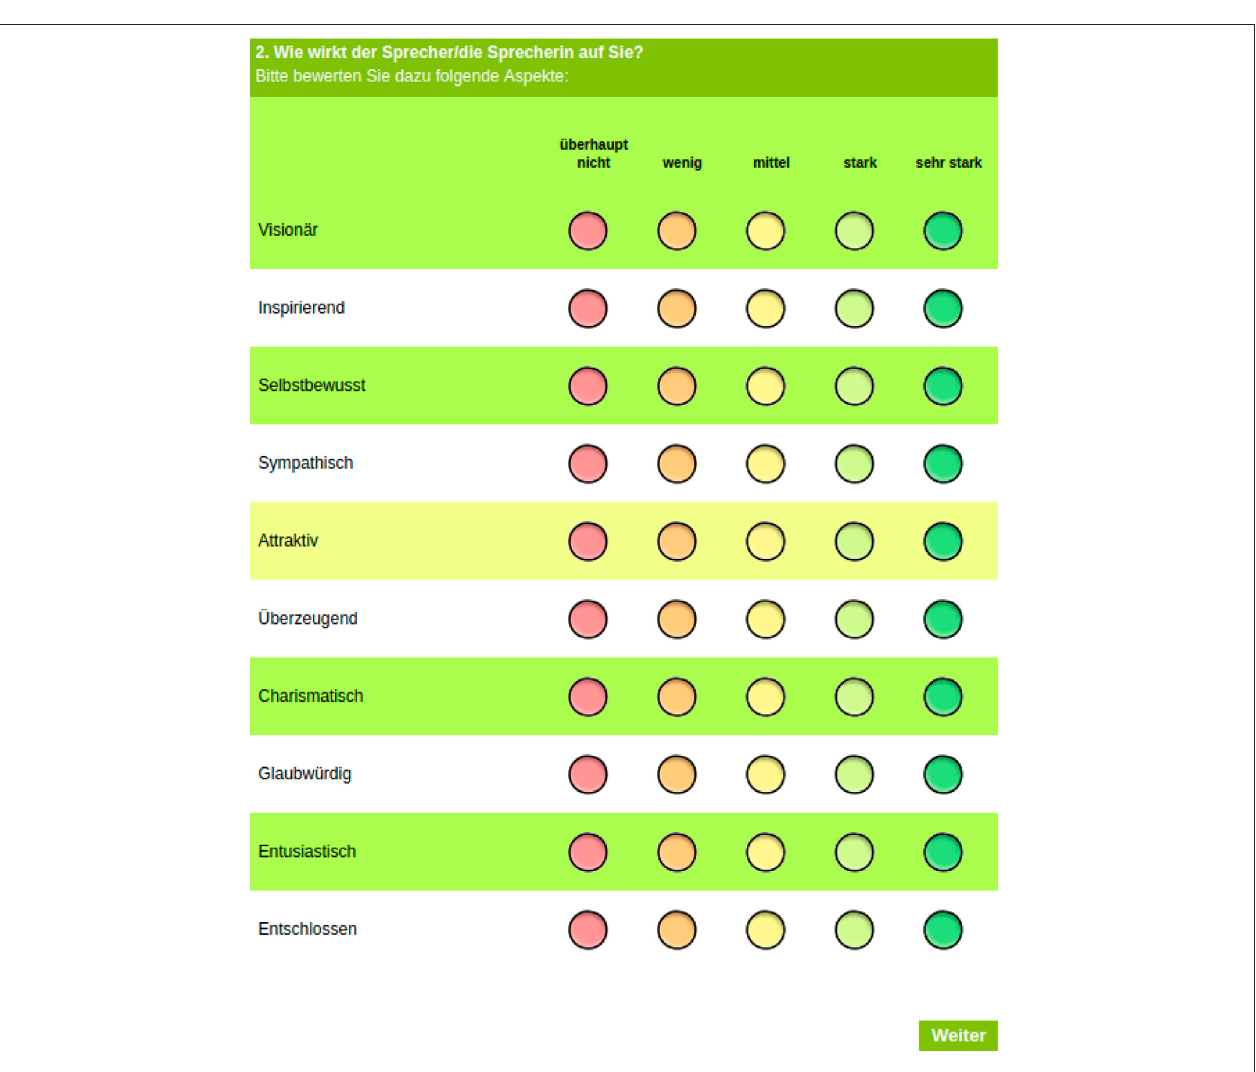
FIGURE 2 | Screenshot of utilized annotation